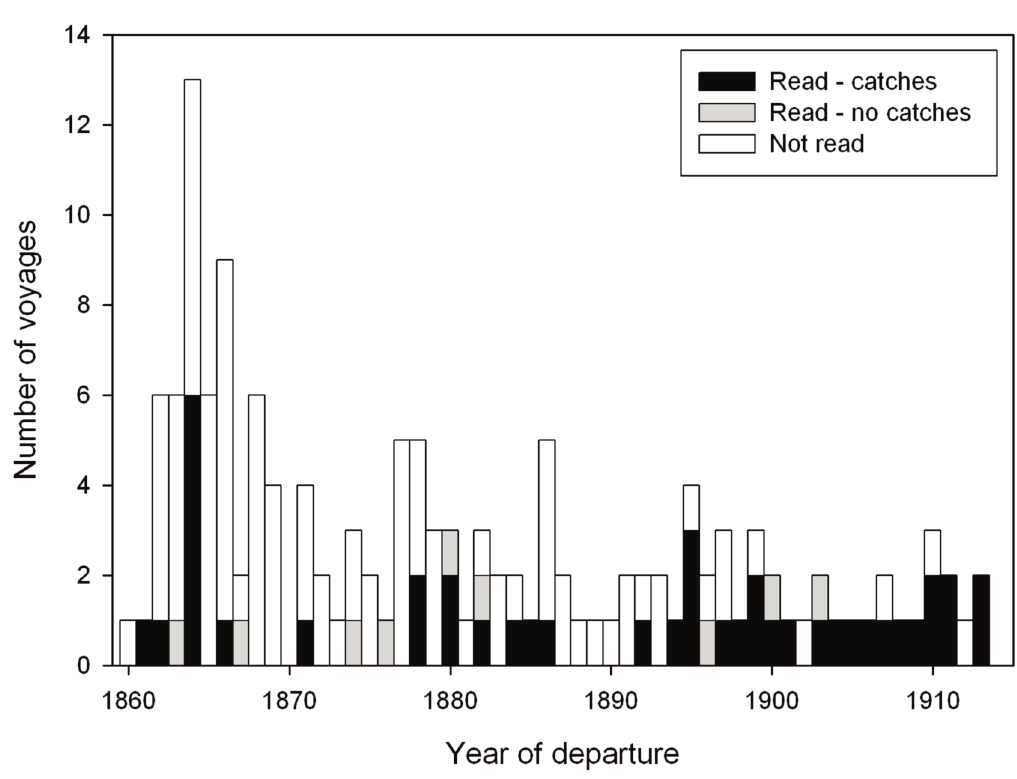
Fig. 20. Catch data were examined from 51 of the 143 whaling voyages into northwestern Hudson Bay between 1860 and 1915. Records were separated into those with logs that were read and provided walrus data (black shading), those with logs that were read but made no mention of walrus catches (grey), and those for which logs were not read